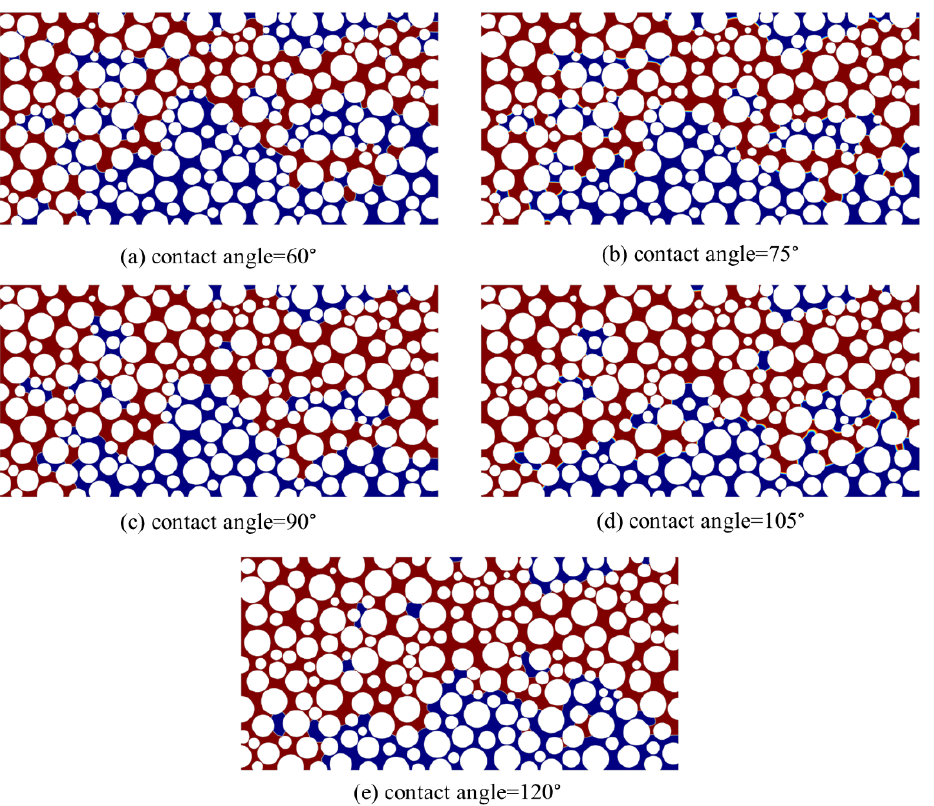
Figure 10. CO 2 saturation distribution after CO 2 flooding for different contact angles (Red and blue regions represent CO 2 and oil, respectively).